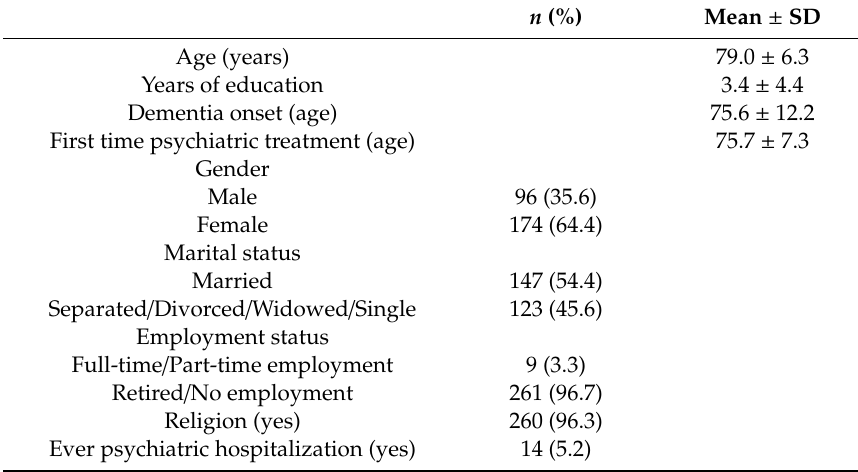
Table 2. Socio-demographic characteristics of people with dementia ( n =